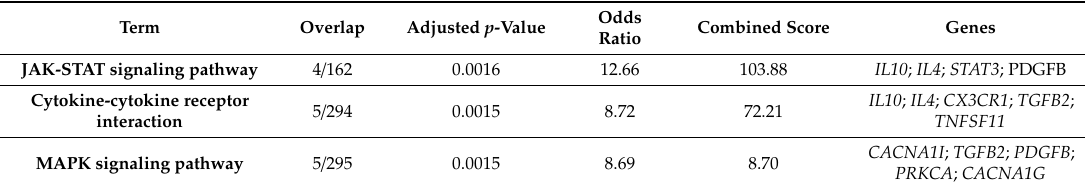
Table 5. Enrichment analysis of pathways related to JAK-STAT signaling pathway by the targets of brevilin A.